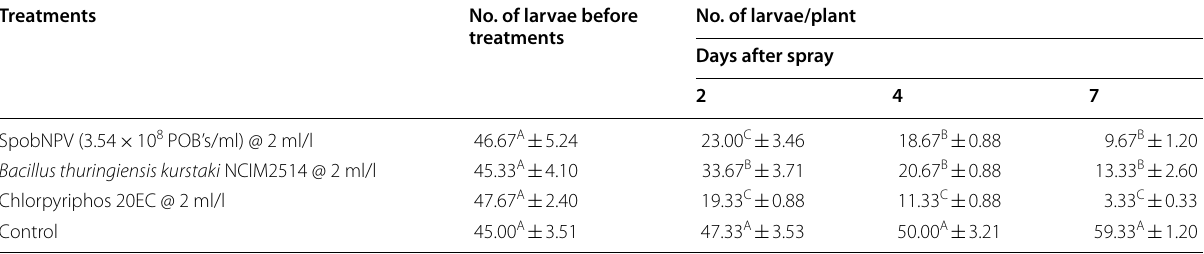
Means followed by different letters within a row indicate significant differences ( P < 0.05; LSD)